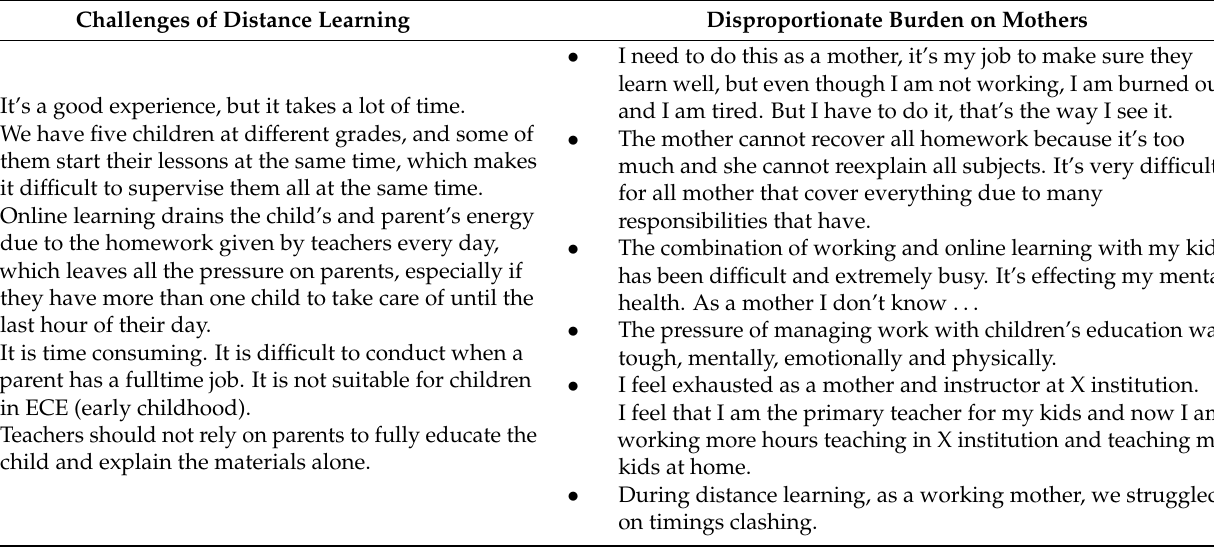
Table 1. Example of themes and their data